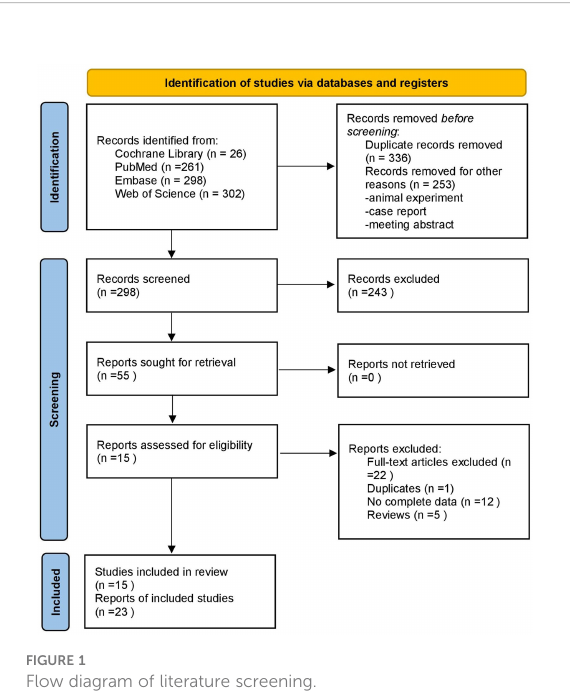
FIGURE 1 Flow diagram of literature